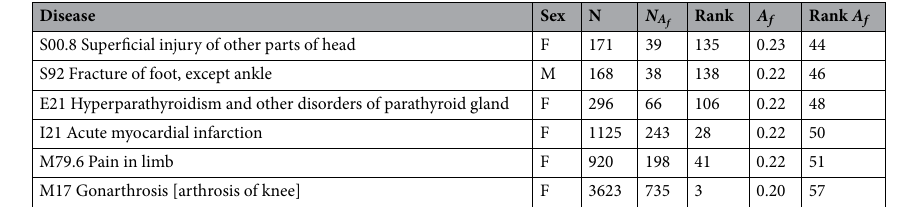
Table 3. The sensitivity analyses found six additional diseases with A f ≥ 0.2 , for the combination of both smoking and BMI, that would have appeared in Table 1. Sex: diseases in males (M) or females (F), N : total cases, N A : attributed f